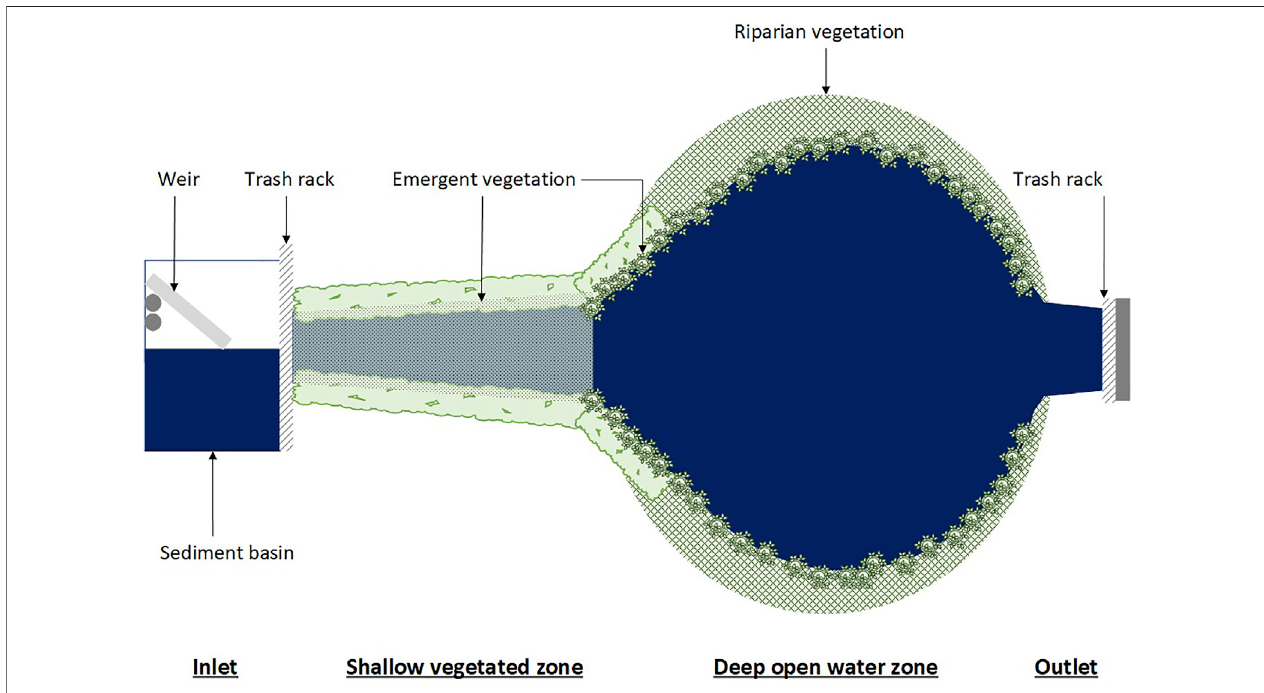
FIGURE 1 | The constructed wetland study site. Diagram is conceptual and not to scale.